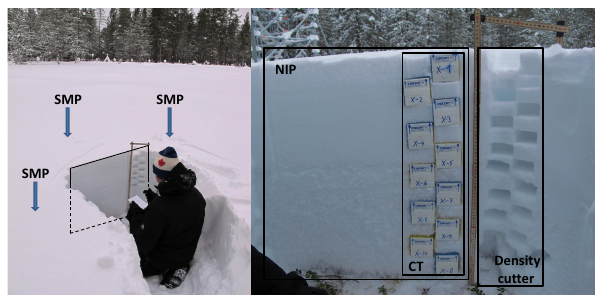
Figure 3. Left: snow-pit overview with the locations of the SnowMicroPen (SMP) measurements (arrows) surrounding the pro- file wall (black rectangular). Right: close-up of the profile wall, with locations of near infrared photography (NIP), computed tomogra- phy (CT) and density cutter